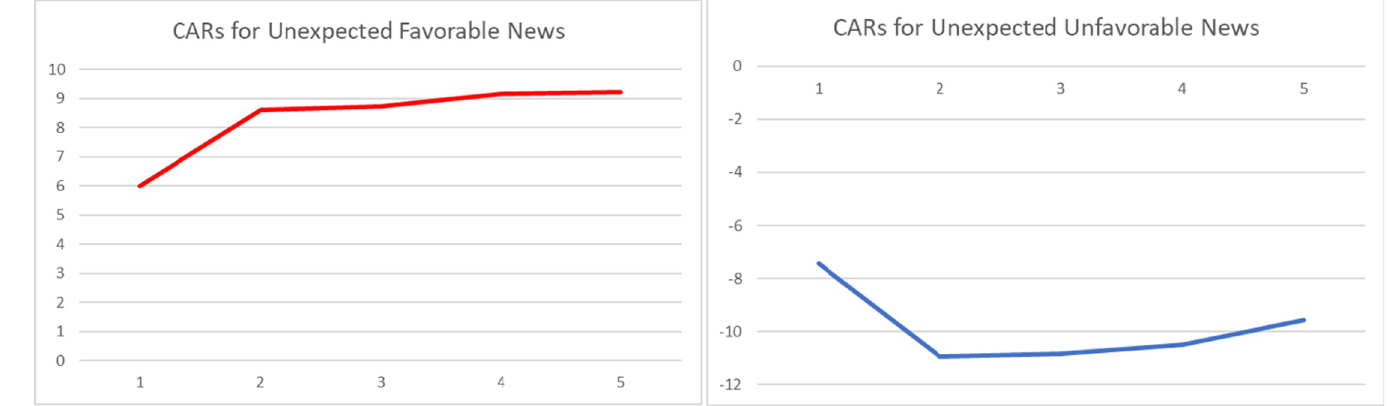
Fig 3. Graphs of daily CARs during a 5-day window following arrival of unexpected event (second period– 1.01.2014 to 10.03.2020).